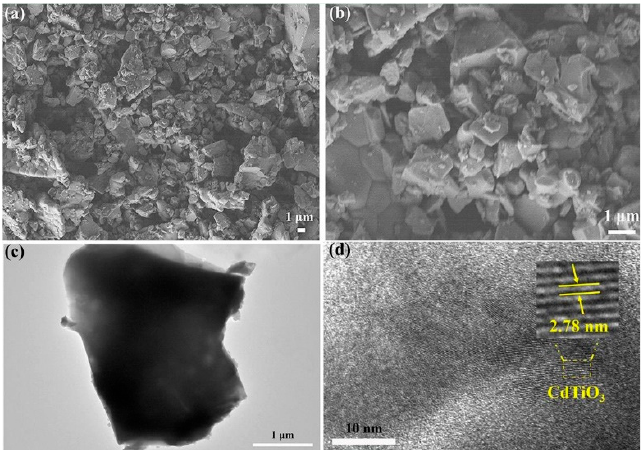
Figure 18. (a,b) SEM and (c ‐ d) TEM images of CdTiO 3 [136].